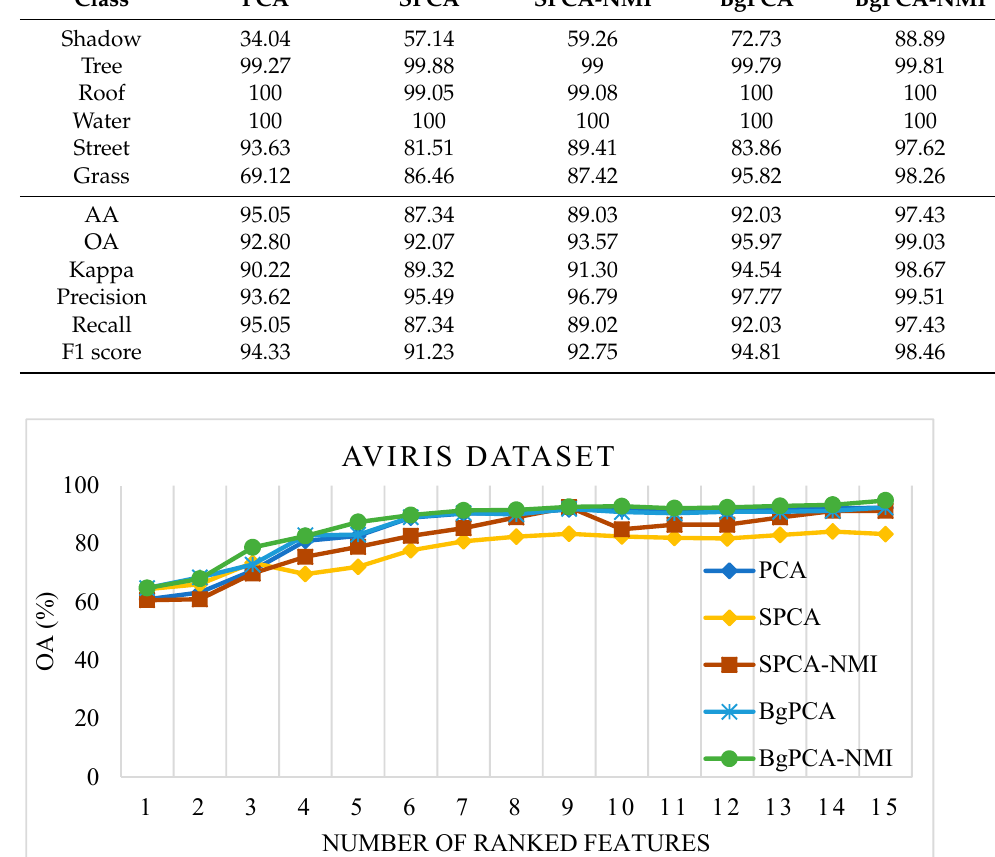
Figure 5. Overall classification accuracy on the AVIRIS dataset.